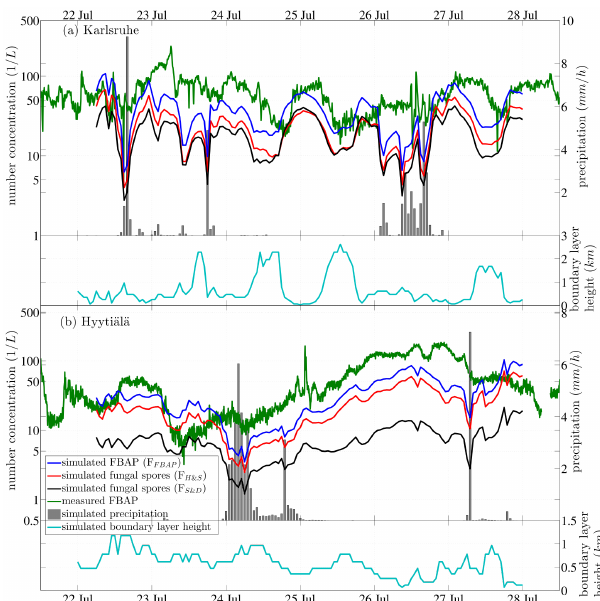
Figure 4. Time series of measured FBAP and simulated fungal spore/FBAP number concentrations in 1L − 1 together with simu- lated precipitation in mmh − 1 (right axis) and simulated bound- ary layer height in kilometers (right axis) during the case study from 11 October 2010 to 21 October 2010 at (a) Karlsruhe, Ger- many, and (b) Hyytiälä, Finland. Simulations were performed with three different emission parameterizations: F H&S from Heald and Spracklen (2009), F S&D from Sesartic and Dallafior (2011), and F FBAP from this